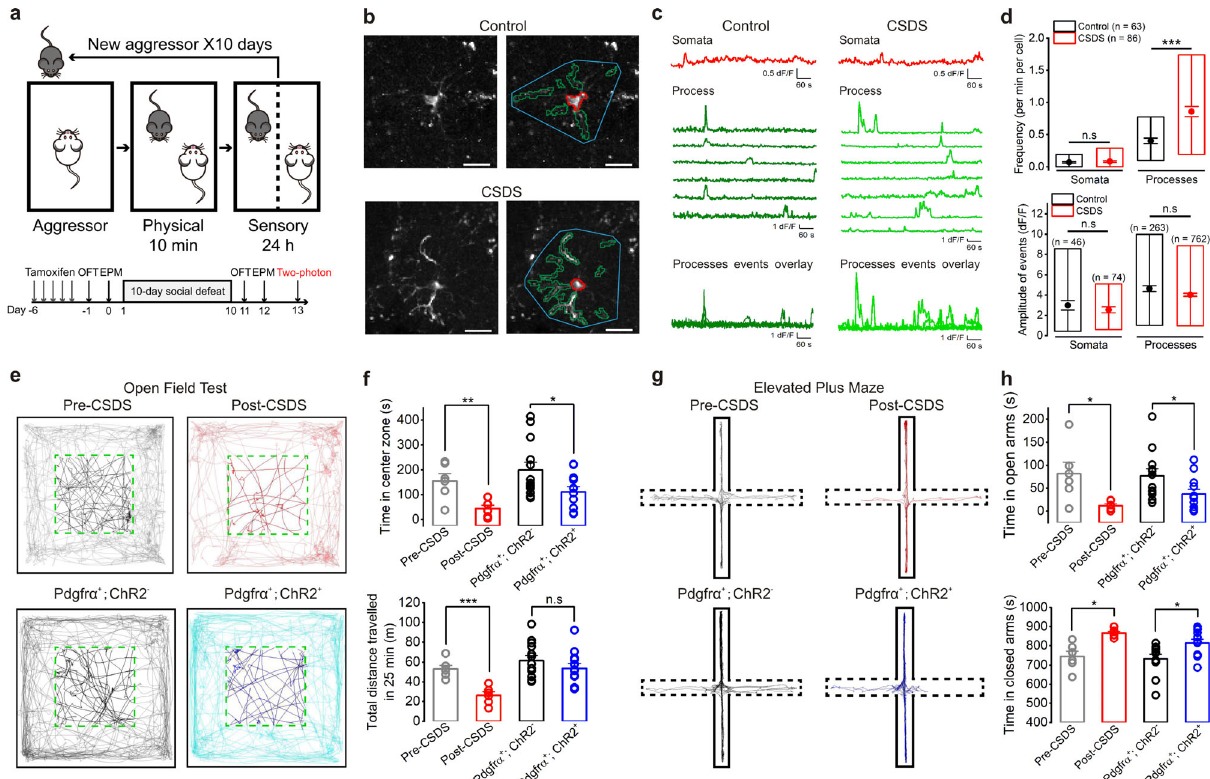
Fig. 6 Increased calcium signals in NG2 glia and enhanced anxiety-like behavior in chronic social defeat stress (CSDS) mice. a Schematic illustrating the experimental approach for calcium imaging and behavioral tests. After 10 consecutive days of CSDS, experimental animals were housed singly to perform the following experiments. b , c Representative images ( b ) and traces ( c ) of Ca 2 + fl uctuations measured in hippocampal NG2 glia from a control mouse and CSDS mouse at postnatal 8 – 12 weeks. Two predominant types of Ca 2 + events are de fi ned: somatic fl uctuations (red), process waves (olive for control and green for CSDS). Approximate territory boundaries are outlined in blue, but these were not used for data analyses and are shown only for illustrative purposes. Scale bars, 20 µ m. d Average data for Ca 2 + fl uctuation properties in control and CSDS mice (from 3 mice for each group). The frequency of Ca 2 + fl uctuations per min per cell is shown in upper panel: somata of control, 0.07 ± 0.01 vs. somata of CSDS, 0.08 ± 0.01, P = 0.9845, two-tailed Mann – Whitney test; processes of control, 0.40 ± 0.04 vs. processes of CSDS, 0.86 ± 0.08; P < 0.0001, two-tailed Mann – Whitney test, *** indicates P < 0.001, n.s. indicates not signi fi cant, n = 63 and 86 cells for control and CSDS, respectively. The amplitude of Ca 2 + fl uctuations is shown in lower panel: